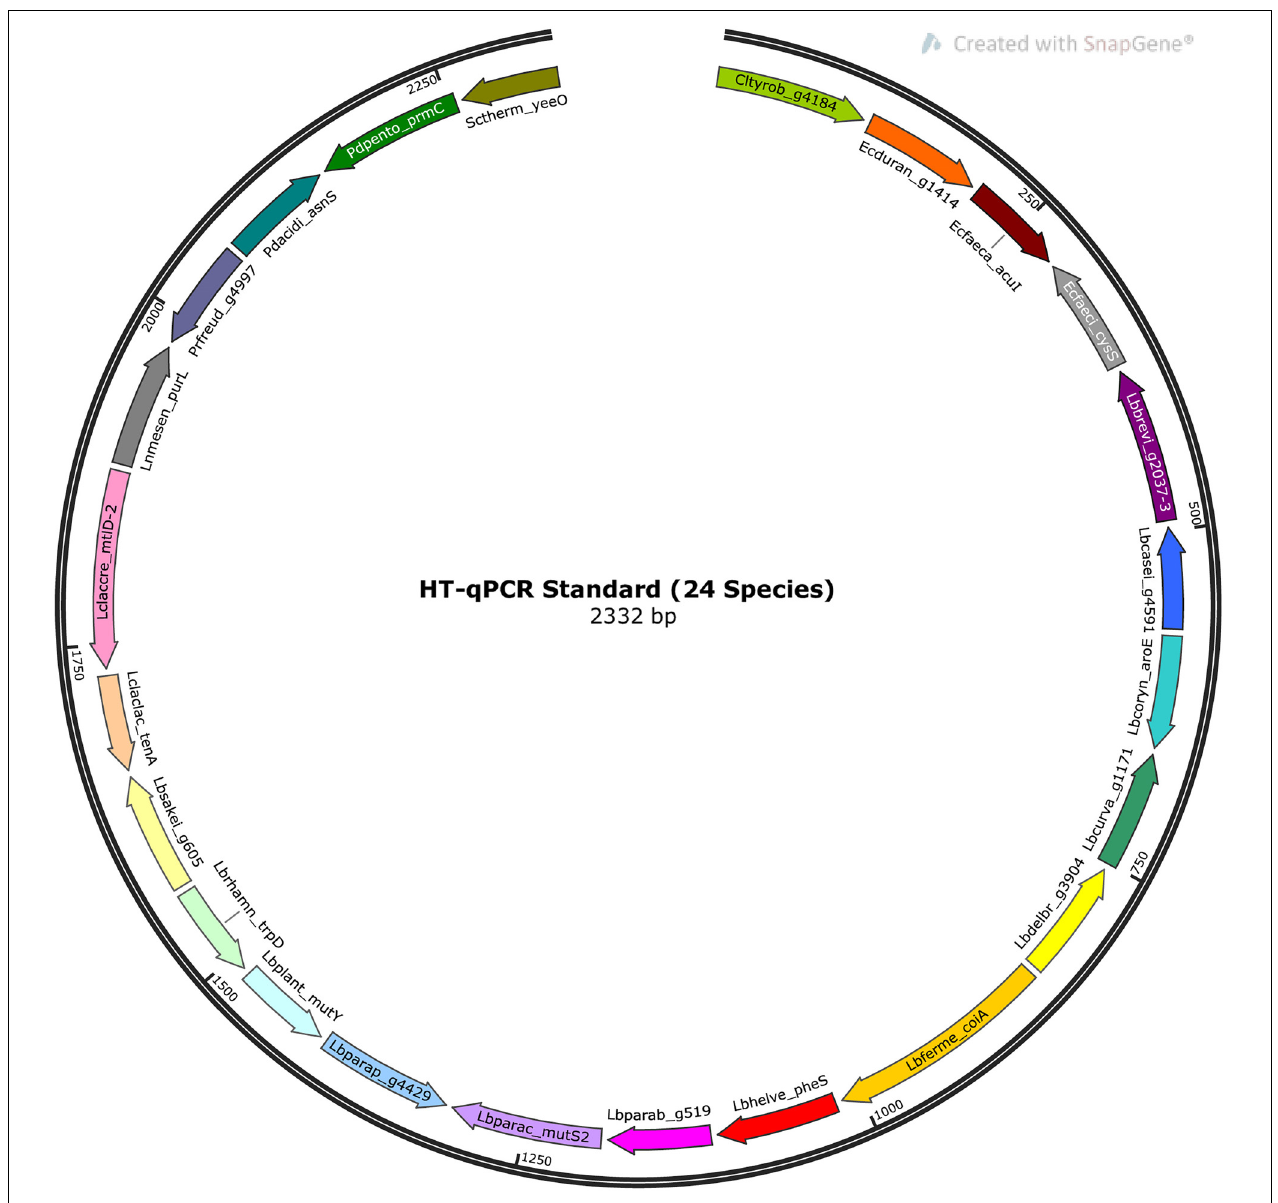
FIGURE 1 | Map representation of the HT-qPCR standard. The standard is a linear, double-stranded DNA molecule 2,332 base pairs in length and consisting of target sequences of 24 species separated by thymine spacers 5 base pairs in length. The map was created using SnapGene Viewer